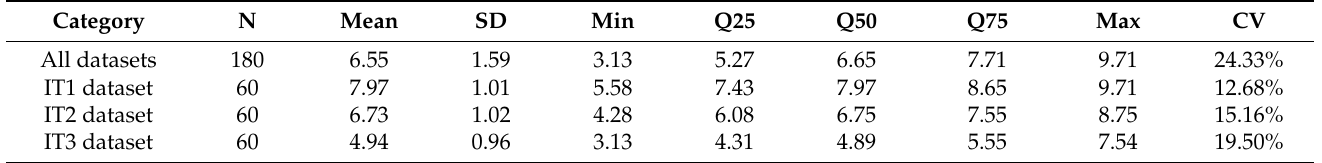
Table 3. Descriptive statistics for the data sets from all test plots and the test plots from the three different irrigation treatments (t · ha − 1